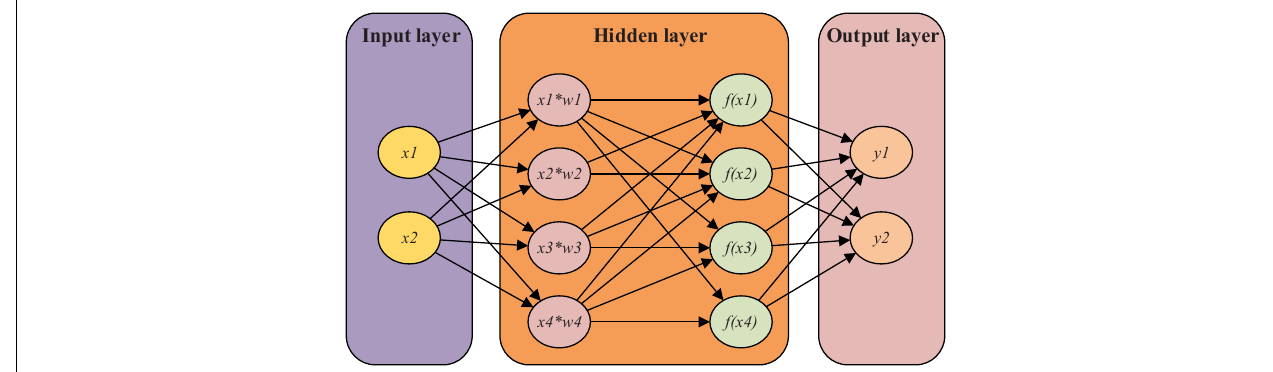
FIGURE 2 | Back propagation neural network (BPNN) structure.